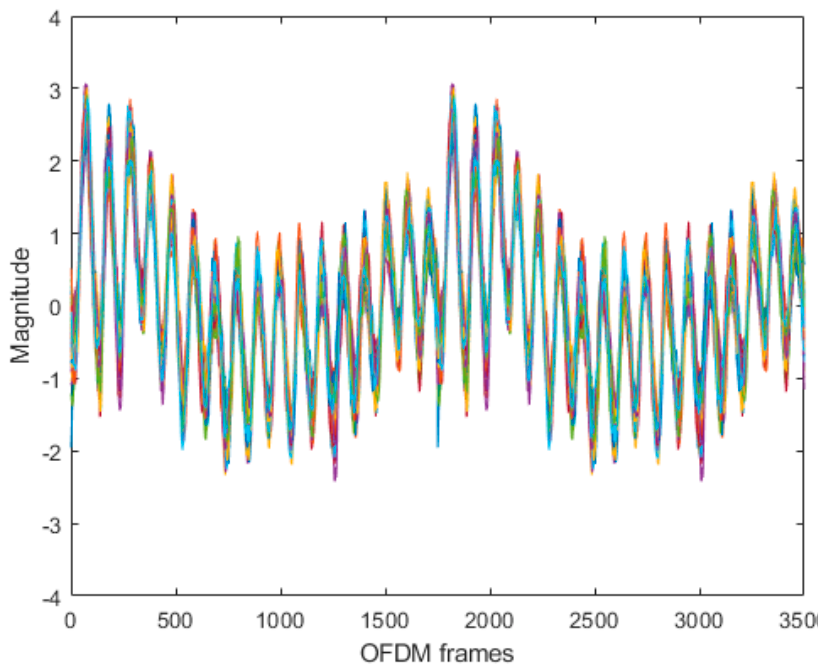
Figure 13. Magnitude response of fast breathing experiment.